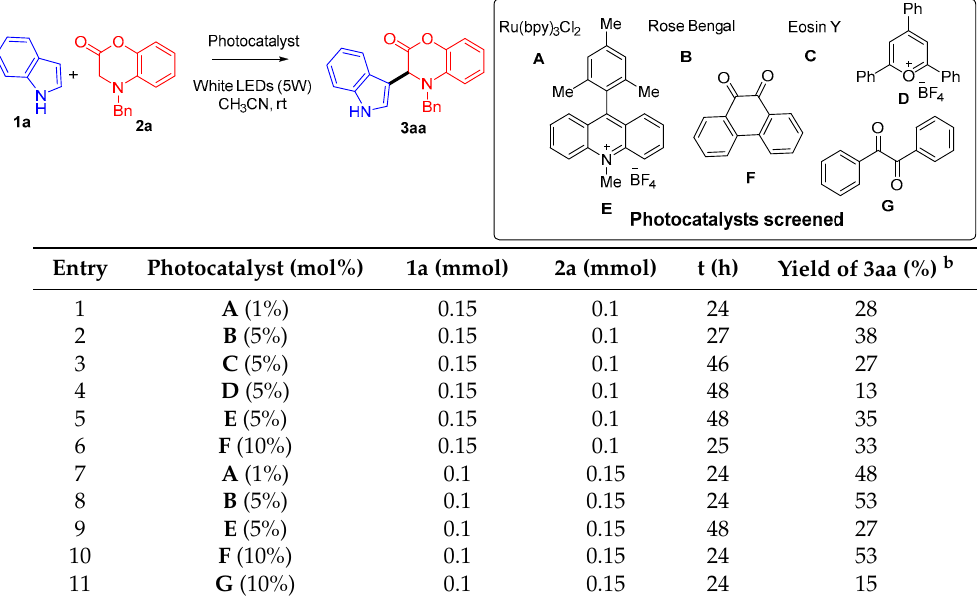
Table 1. Preliminary optimization of the reaction conditions a .